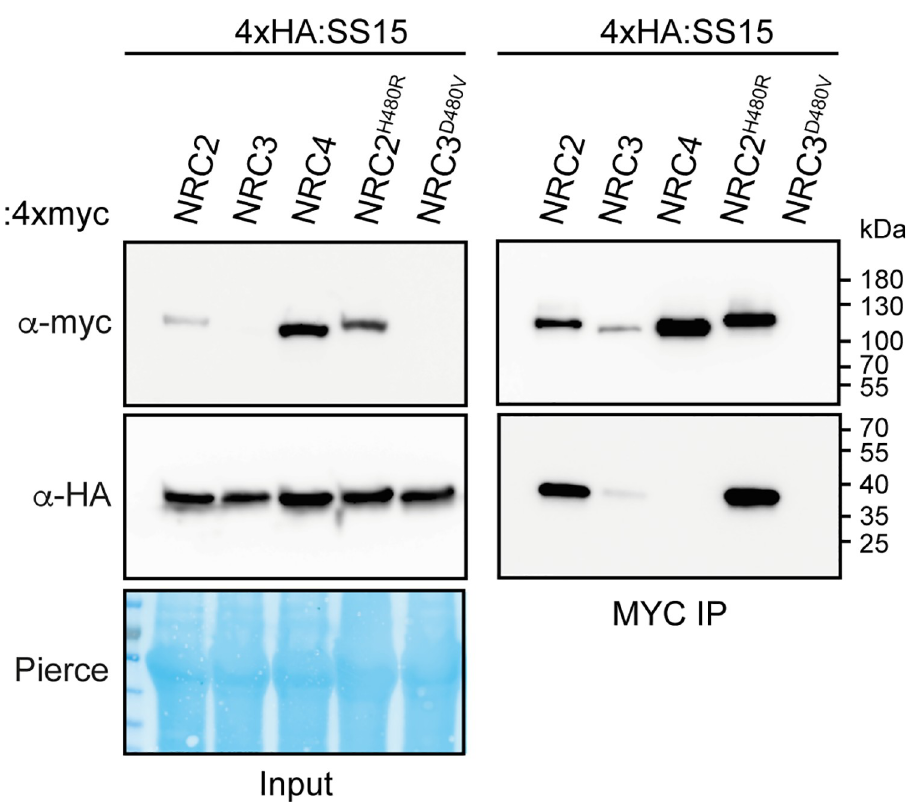
Fig 8. SS15 associates with autoactive NRC2. N-terminally 4xHA-tagged SS15 was transiently coexpressed in N . benthamiana with C-terminally 4xMyc tagged-NRC2, NRC3, NRC4, NRC2 H480R , NRC3 D480V , and NRC4 D478V . IP was performed with agarose beads conjugated to Myc (Myc IP) antibodies. Total protein extracts (Input) and proteins obtained by coIP were immunoblotted with appropriate antisera labelled on the right. Approximate molecular weights (kDa) of the proteins are shown on the right. Rubisco loading controls were conducted using Pierce staining. This experiment is representative of 2 independent replicates. coIP, co-immunoprecipitation; IP, immunoprecipitation.